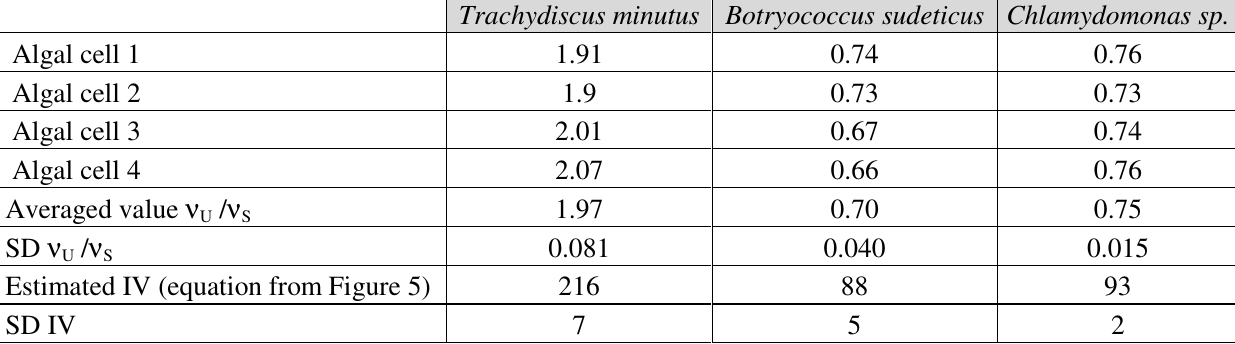
Table 4. Fatty acid composition of the lipid fraction of Trachydiscus minutus determined from a GC-MS analysis. Molar ratios n of the individual fatty acids in the algal lipid i fraction are used to determine the average mass unsaturation ratio N i )/ Σ ( n i ) as Σ ( n N N . For the data given below, the actual value of N C=C /N CH2 = 0.181 i C=C i CH2 which corresponds to IV =